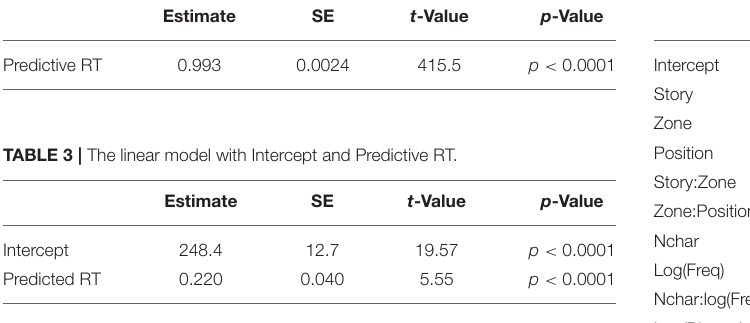
TABLE 2 | The linear model with Predictive RT as the only independent variable. Estimate